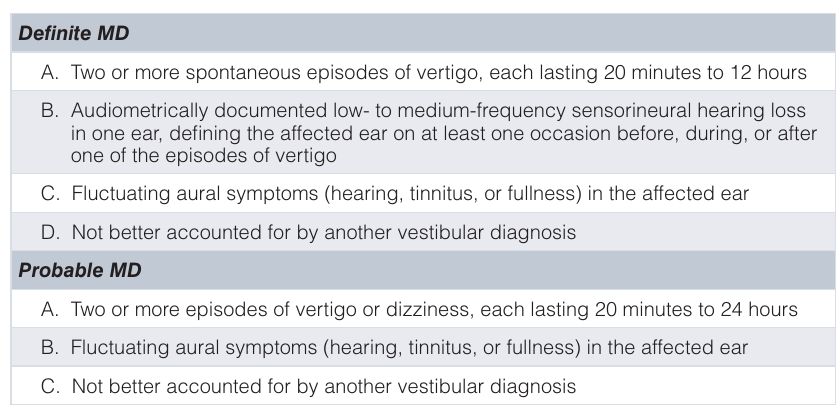
Table 1. Diagnostic criteria for definite and probable Ménière’s disease (MD) 1